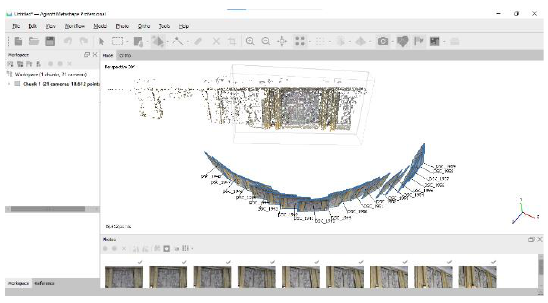
Fig 12. Results after image orientation.